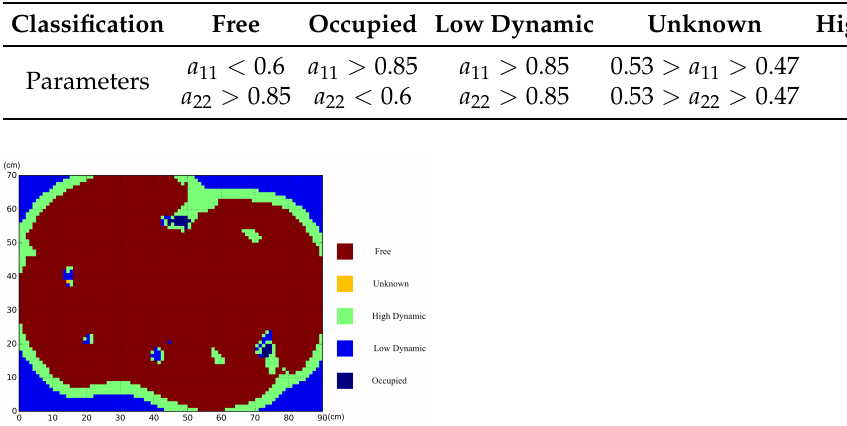
Table 2. Classification for the dynamic environments. When the space does not belong to any class in the previous four, it is classified as high dynamic.